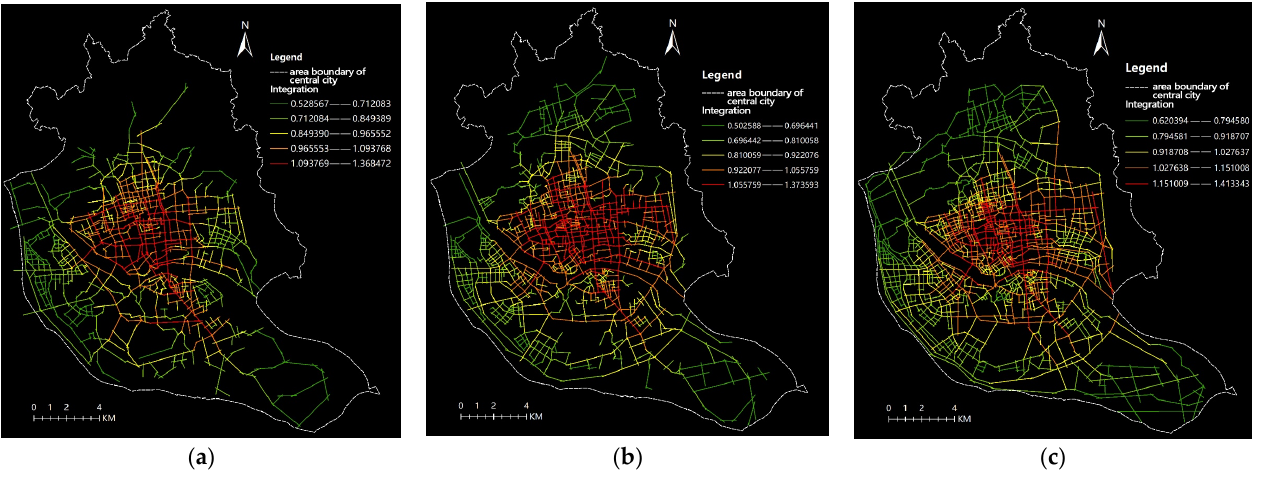
Figure 3. Street global integration in the central area of Fuzhou City: ( a ) Street global integration of 2000; ( b ) Street global integra Table 2010. ( c ) Street global integration of 2021. The red line is the most integrated street; the green line is the least integrated street. Table 3. Descriptive analysis of street global integration in the Central Area of Fuzhou City for 2000, 2010, 2021.